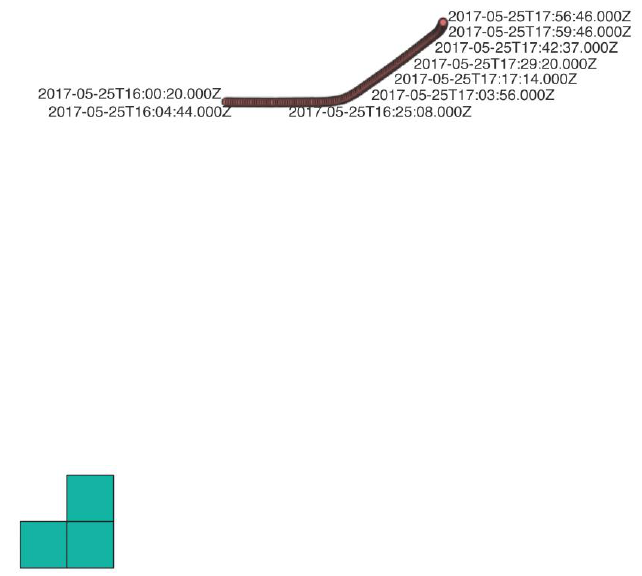
Figure 5. The output of SRP for ship 81, when using KNN-WD.